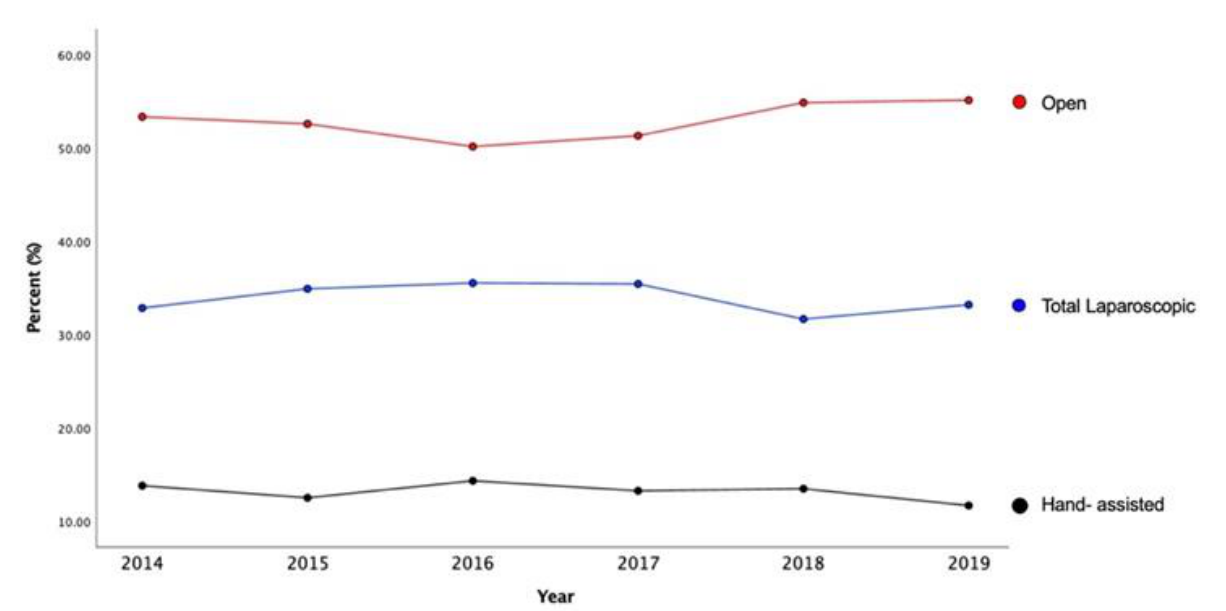
Figure 1. Time Trends of All Patients Undergoing Distal Pancreatectomy by Surgical Approach.